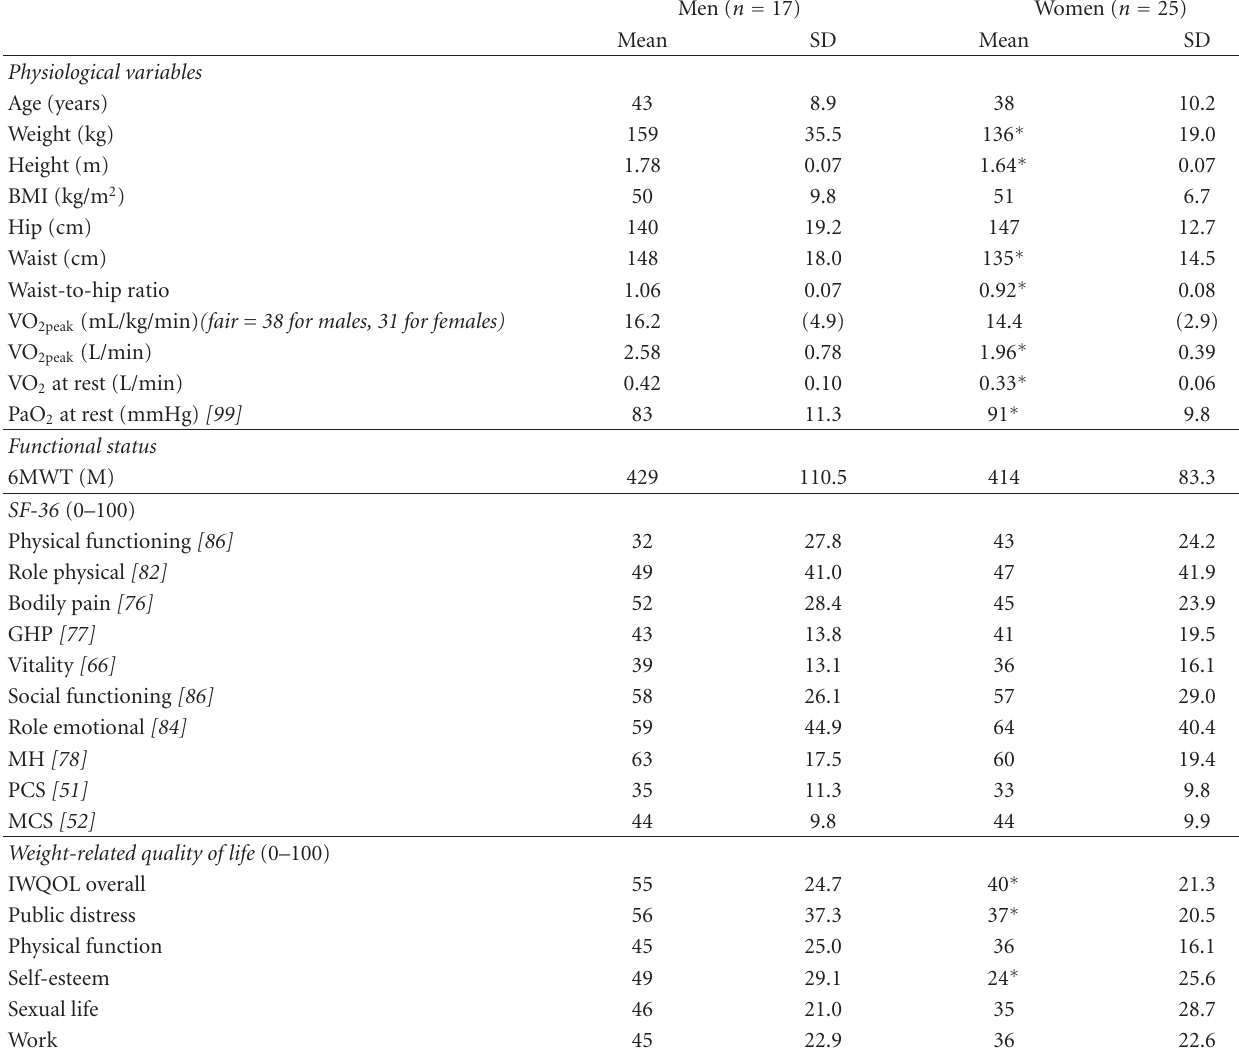
Table 1: Characteristics of the study population by